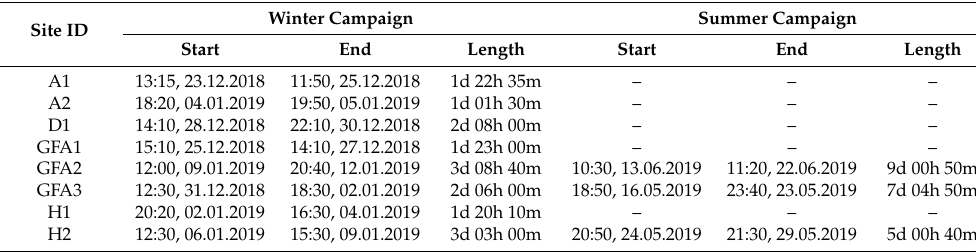
Table 2. Measurement periods and lengths of the two campaigns.